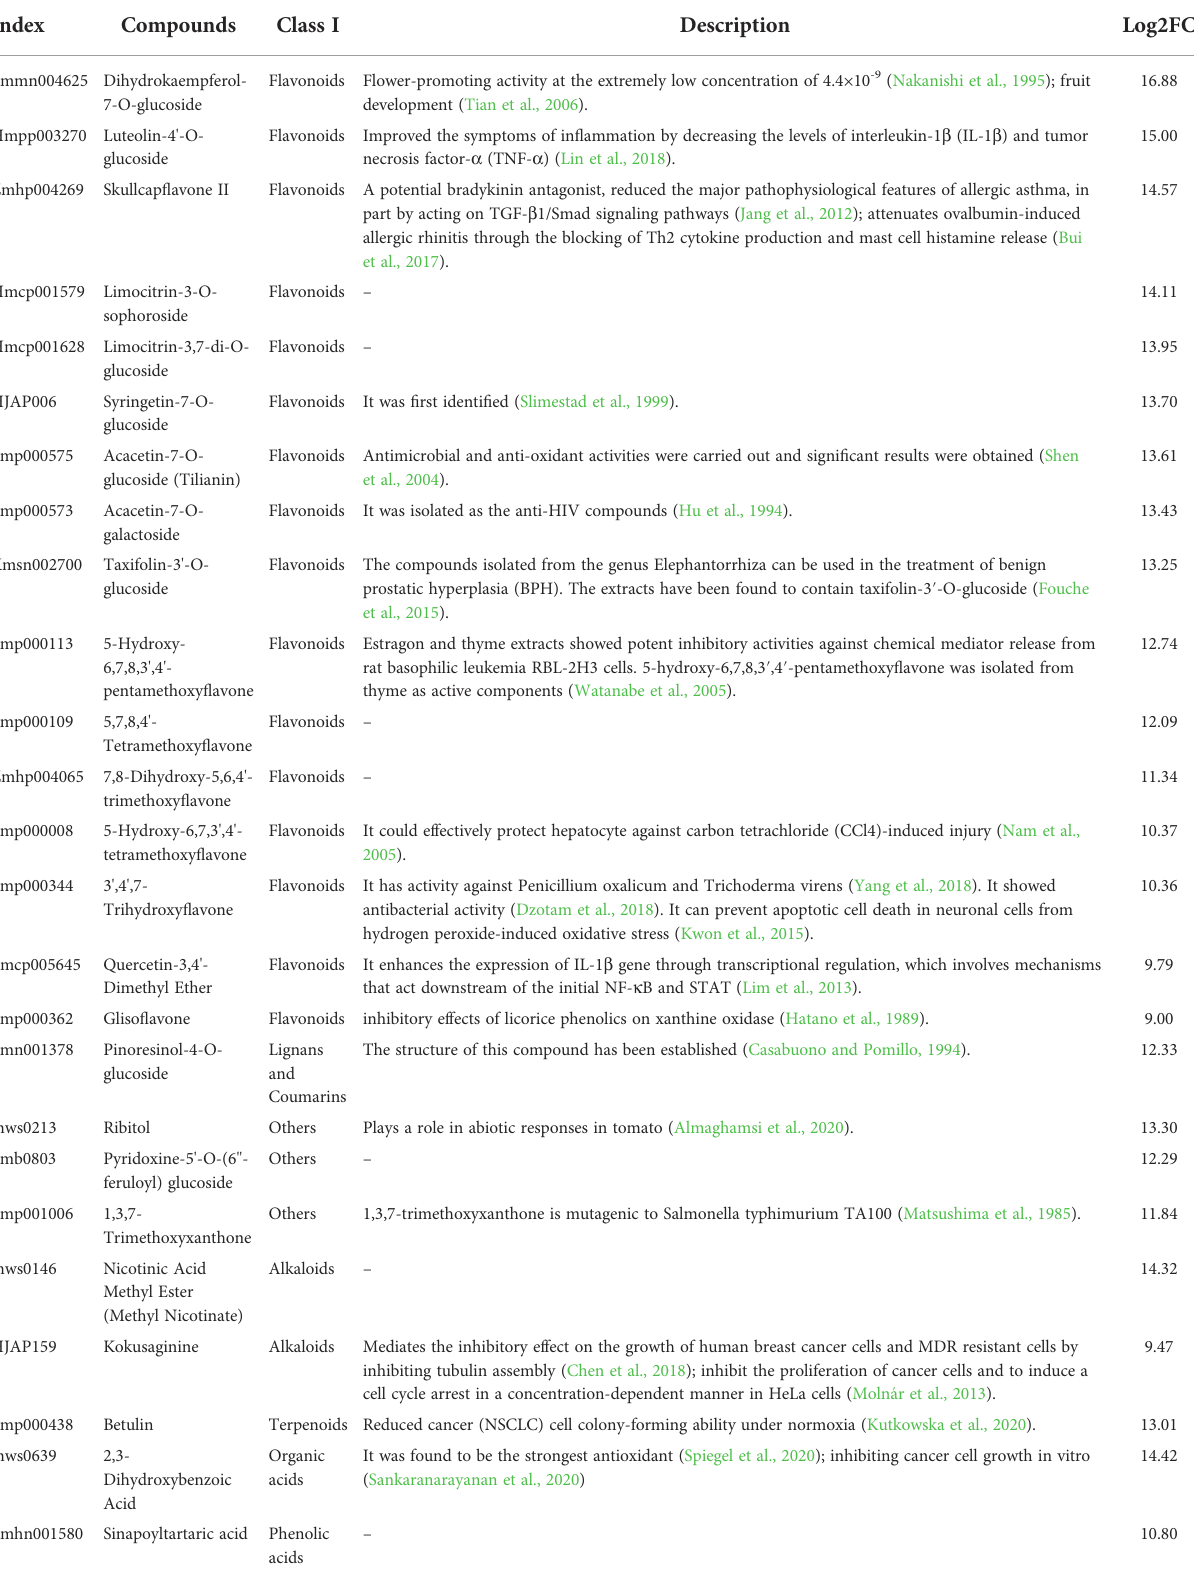
TABLE 1 25 DAMs that were expressed in OEGA